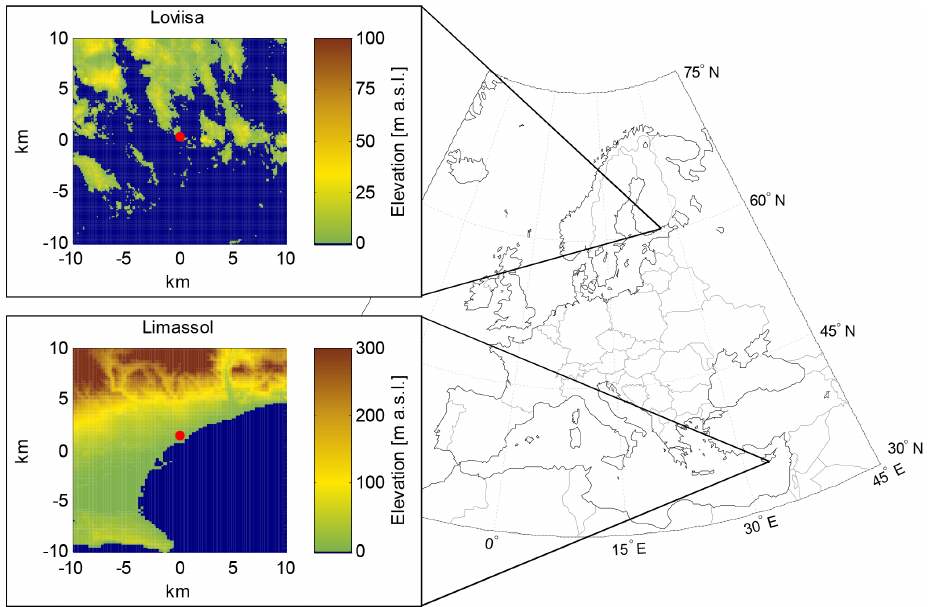
Figure 1. Location of Loviisa and Limassol measurement sites. In the 20km × 20km topographic map inserts for Loviisa (National Land Survey of Finland, 2014) and Limassol (United States Geological Survey, 2014) the location of the lidar is indicated by a red dot.